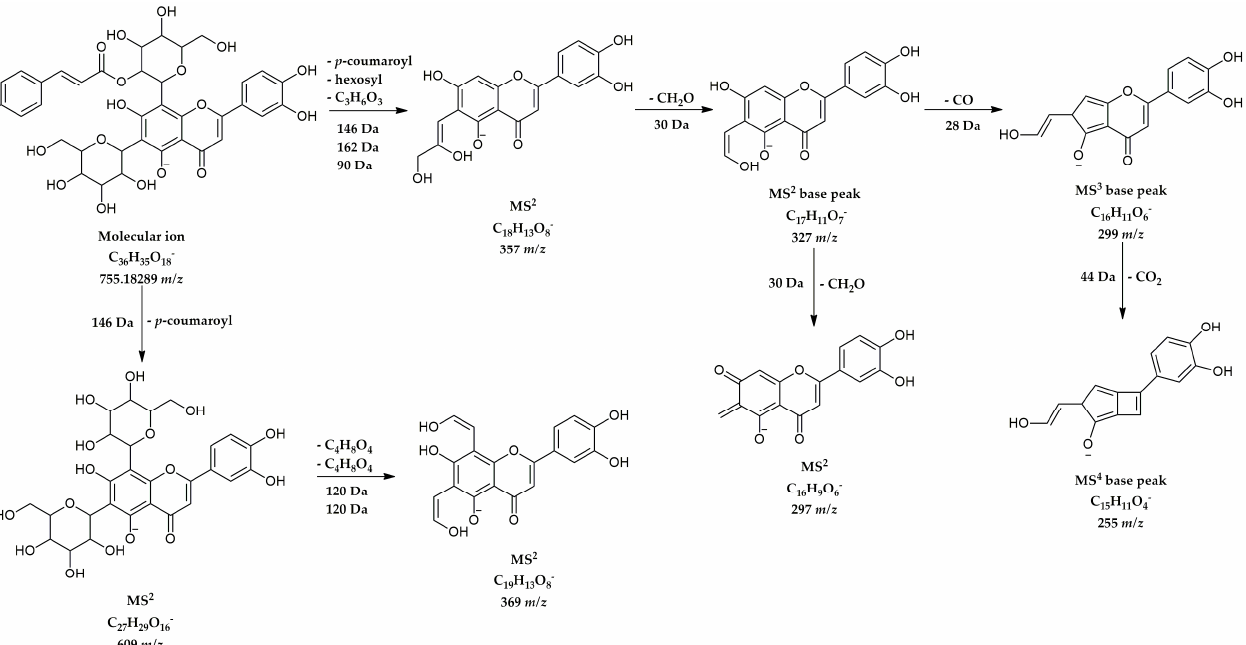
Figure 2. UHPLC-MS 4 Orbitrap chromatogram (negative ionization mode) of R. holostea aerial part methanolic extract. Compounds 14 , 27 , 30 and 33 are not visible in this plot, as their peaks are below the baseline.